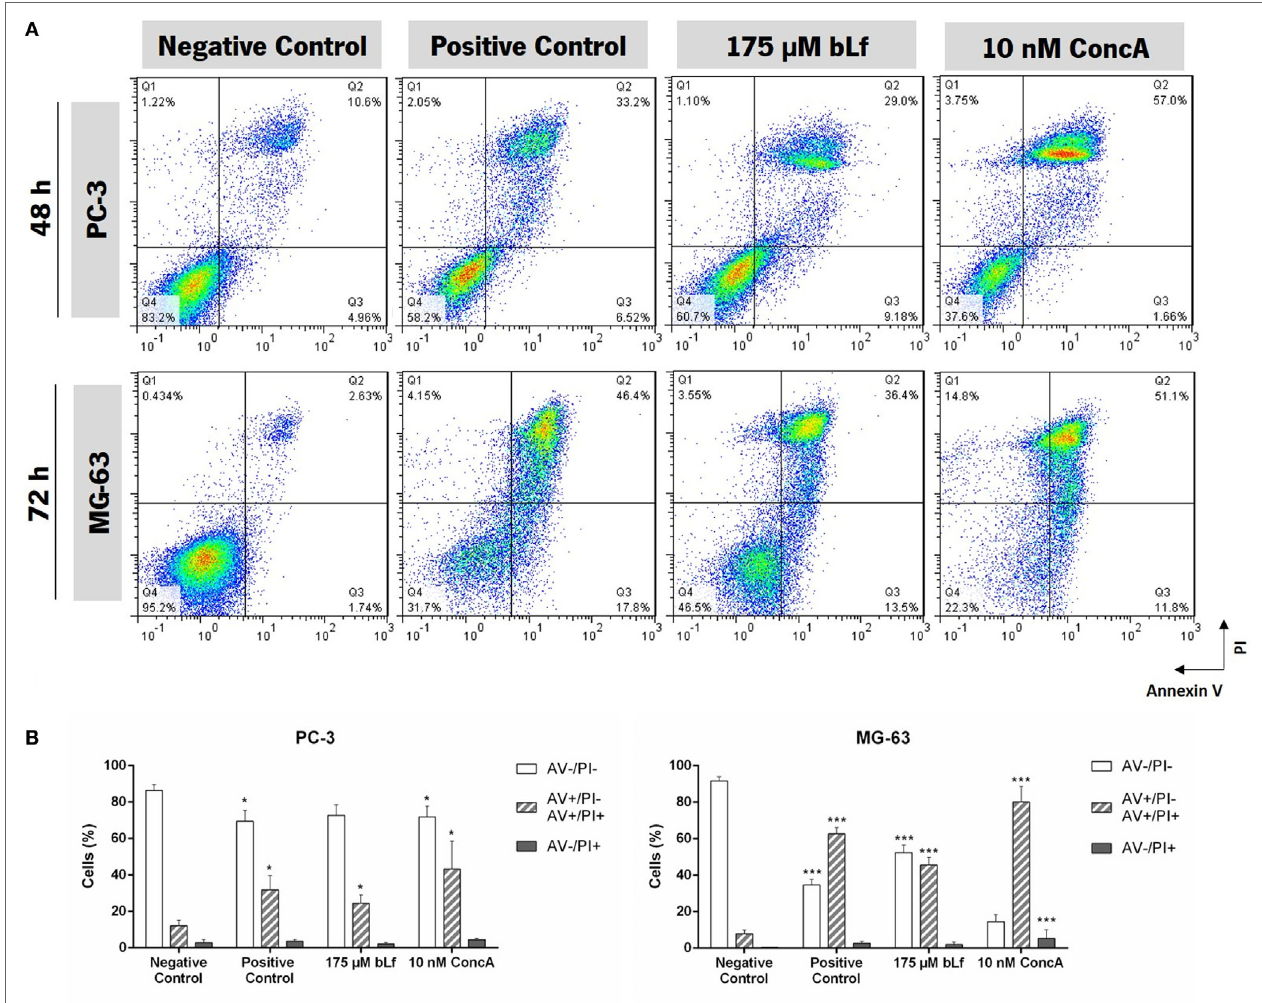
FigUre 2 | Bovine lactoferrin (bLf) induces cell death of the highly metastatic cancer cell lines PC-3 and MG-63. (a) Exposure of phosphatidylserine induced by bLf or concanamycin A (ConcA) monitored by AV-FITC/PI staining. Representative histograms of cells untreated (negative control) or treated during 48 h (for PC-3) and 72 h (for MG-63) with 175 µM bLf or 10 nM ConcA, or with 50 µM cisplatin or 60 µM etoposide (used as positive controls, for MG-63 and PC-3 cells, respectively). (B) Quantitative analysis of the AV/PI assays in panel (a) . Values represent mean ± SD of three independent experiments, * P < 0.05 and *** P < 0.001 when compared with negative control